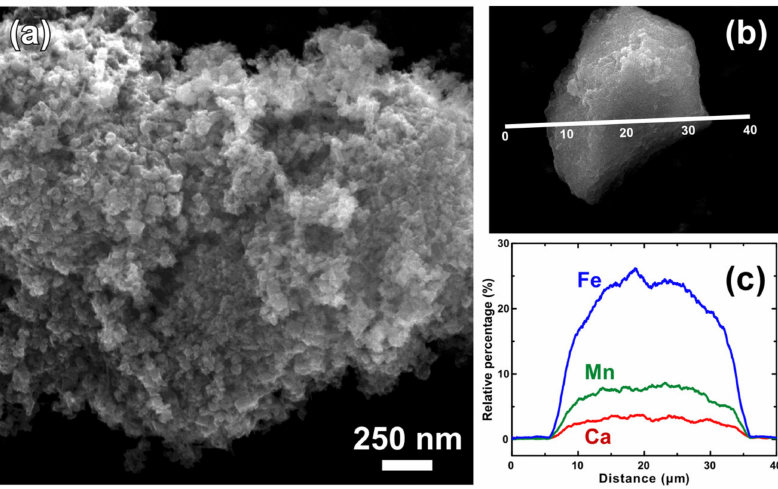
Figure 2. ( a ) Higher magnification FE-SEM image showing the nanoscale morphology of TMFx-Ca; ( b ) lower magnification FE-SEM image of one granule from this adsorbent; and ( c ) the respective elemental distribution of Fe, Mn, and Ca, as obtained by line-scan analysis in this granule.